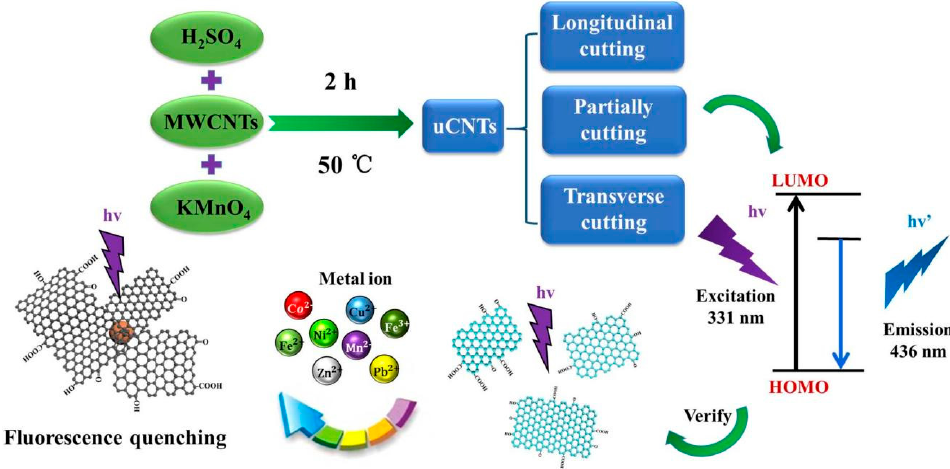
Figure 1. Illustration of the formation process of uCNT and its corresponding energy.